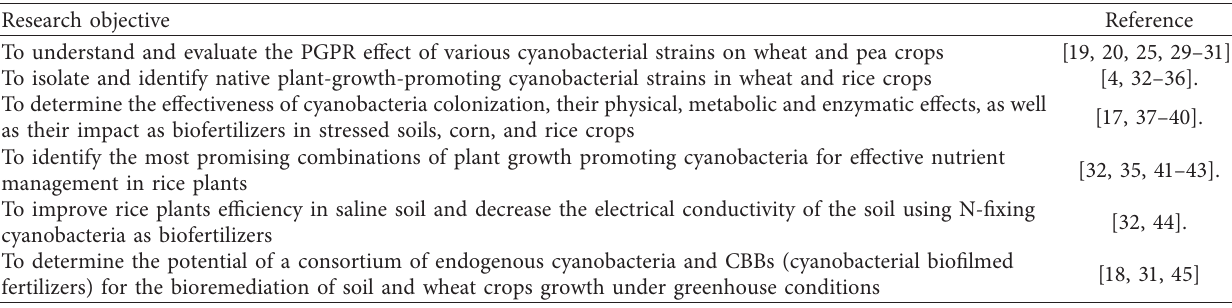
Figure 2: Country of origin of publications found in the systematic review and most reported cyanobacterial genera. Source: own elaboration Table 2: Research